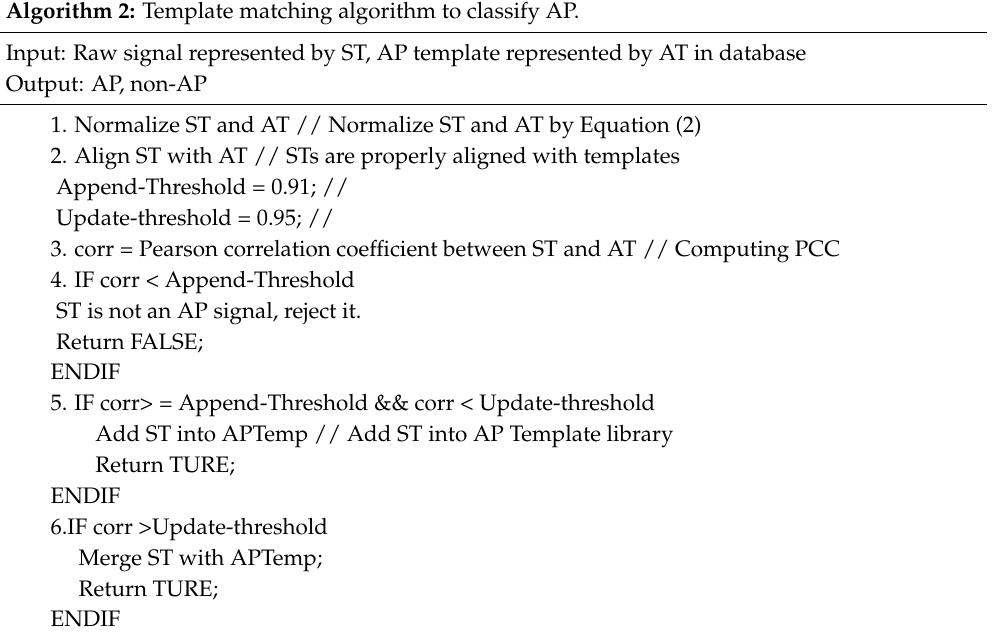
Figure 3. A case of eight AP templates. Algorithm 2: Template matching algorithm to classify AP.